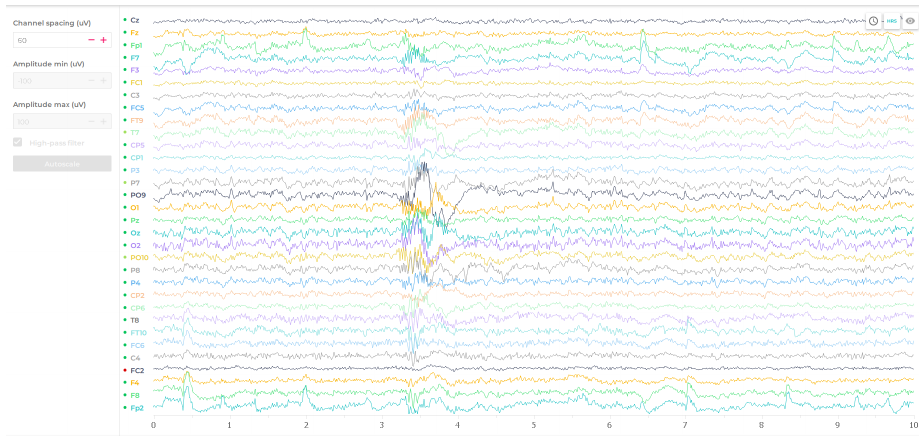
Figure 12. An example of a nervous tic involving the lifting of the left shoulder (shoulder muscle